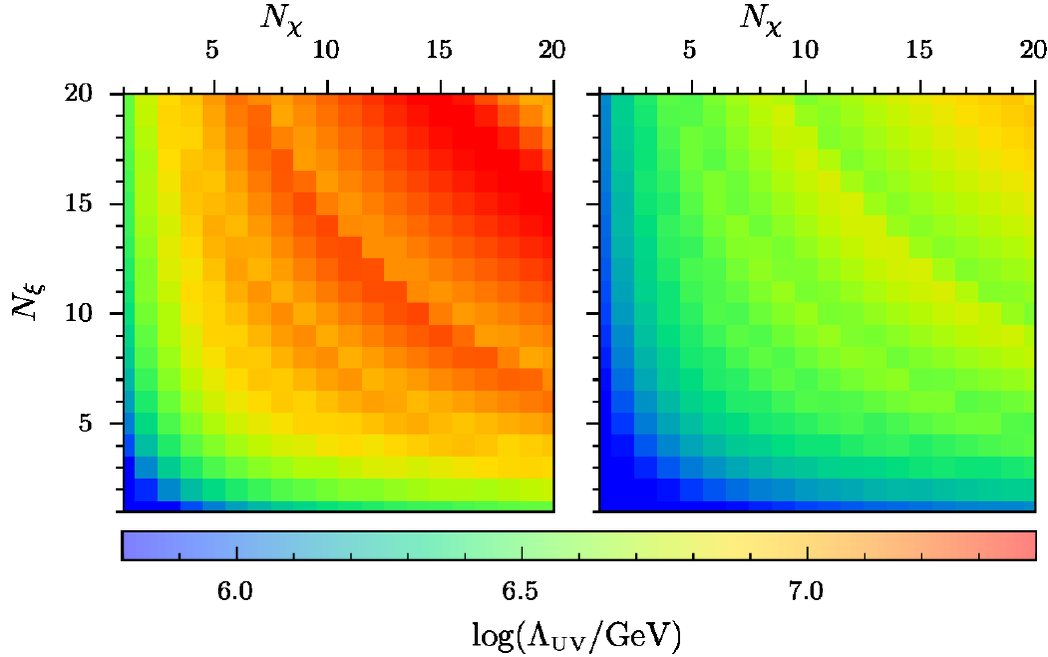
Figure 5 . Largest possible UV scale in extensions of the conformal SM by two real scalar SU(2) L multiplets with vanishing vevs. The results were obtained using RGEs including Left : scalar con- tributions only. Right : scalar and top-quark